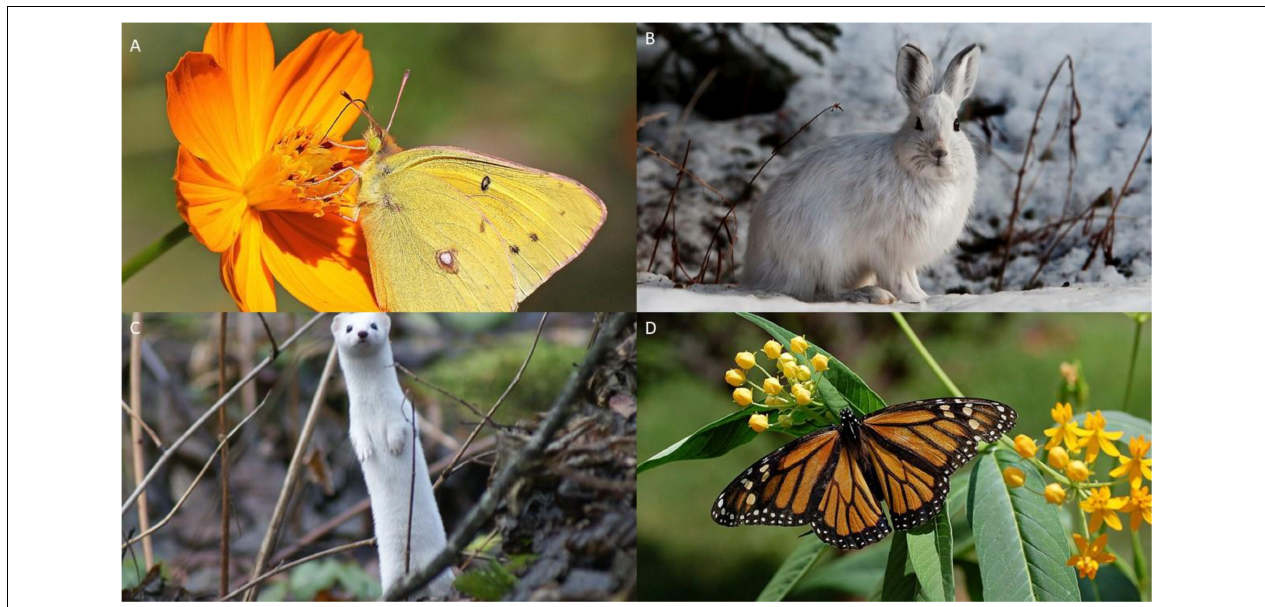
FIGURE 2 | Animals whose colors are impacted by climate change. (A) The Orange sulfur butterfly ( Colias eurytheme ) in Nogales, Arizona by Alan Schmierer. C. eurytheme relies on wing color to reach optimal temperatures for flying and foraging. (B) Snowshoe hare ( Lepus americanus ) in Denali National Park by Tim Rains. Snowshoe hares are increasingly experiencing camouflage mismatch with decreases in snow cover due to climate change. (C) Least weasel ( Mustela nivalis ) in Bialowieza Forest by Stormbringer76. Weasels in their winter pelage are also experiencing camouflage mismatch with decreasing snow cover and period. (D) Monarch butterfly ( Danaus plexippus ) in Aston Township, Pennsylvania by Derek Ramsey. Monarch wing color darkness is important for flight endurance during